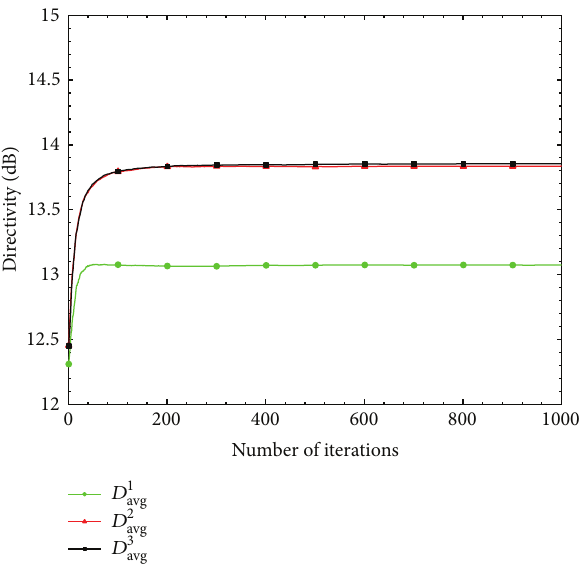
Figure 9: Sideband level variation of the three methods for IS— Ω 𝑘 representsthemaximumsidebandleveland 𝑘 representsthemethod used, where 𝑘 = 1 : SBL, 𝑘 = 2 : SR, and 𝑘 = 3 : SB.